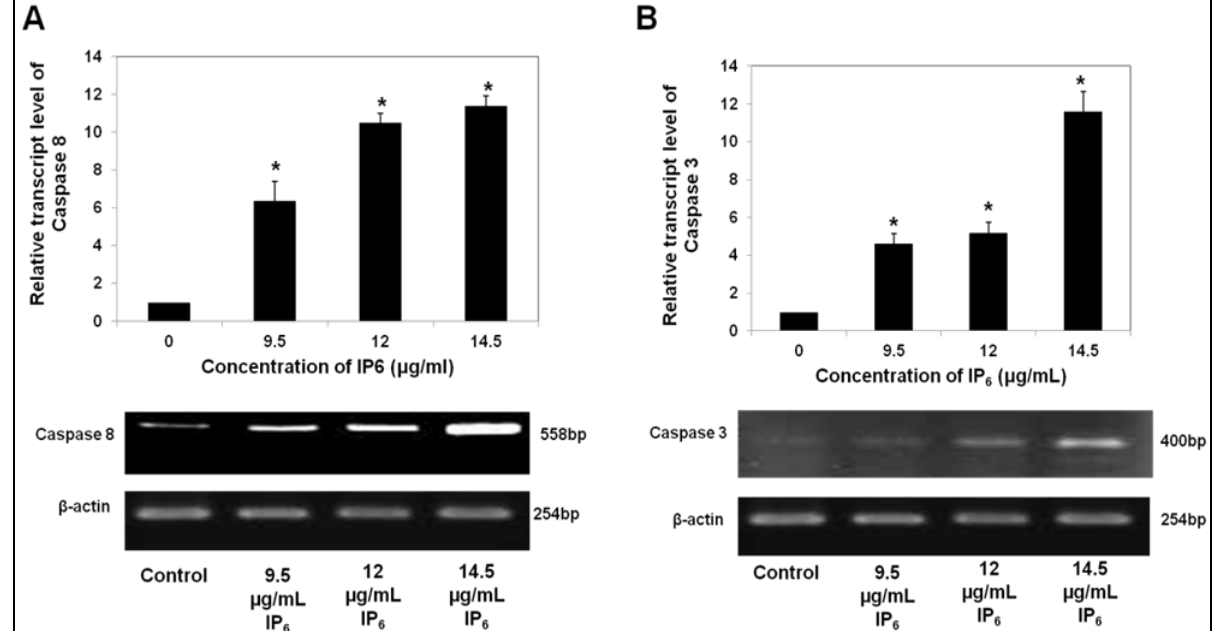
Figure 2. Expression of caspases at mRNA level of HT-29 cells incubated with IP 6 ( A ) upregulation of caspase-8 and ( B ) upregulation of caspase-3 in a dose-dependent manner. HT-29 cells were incubated with IP (9.5, 12.0 or 14.5 µg/mL) for 72 h at 37 °C. 6 Results are from 3 independent experiments and presented as the mean ± SD. * indicate significant difference by Tukey’s test ( p < 0.05) relative to their respective